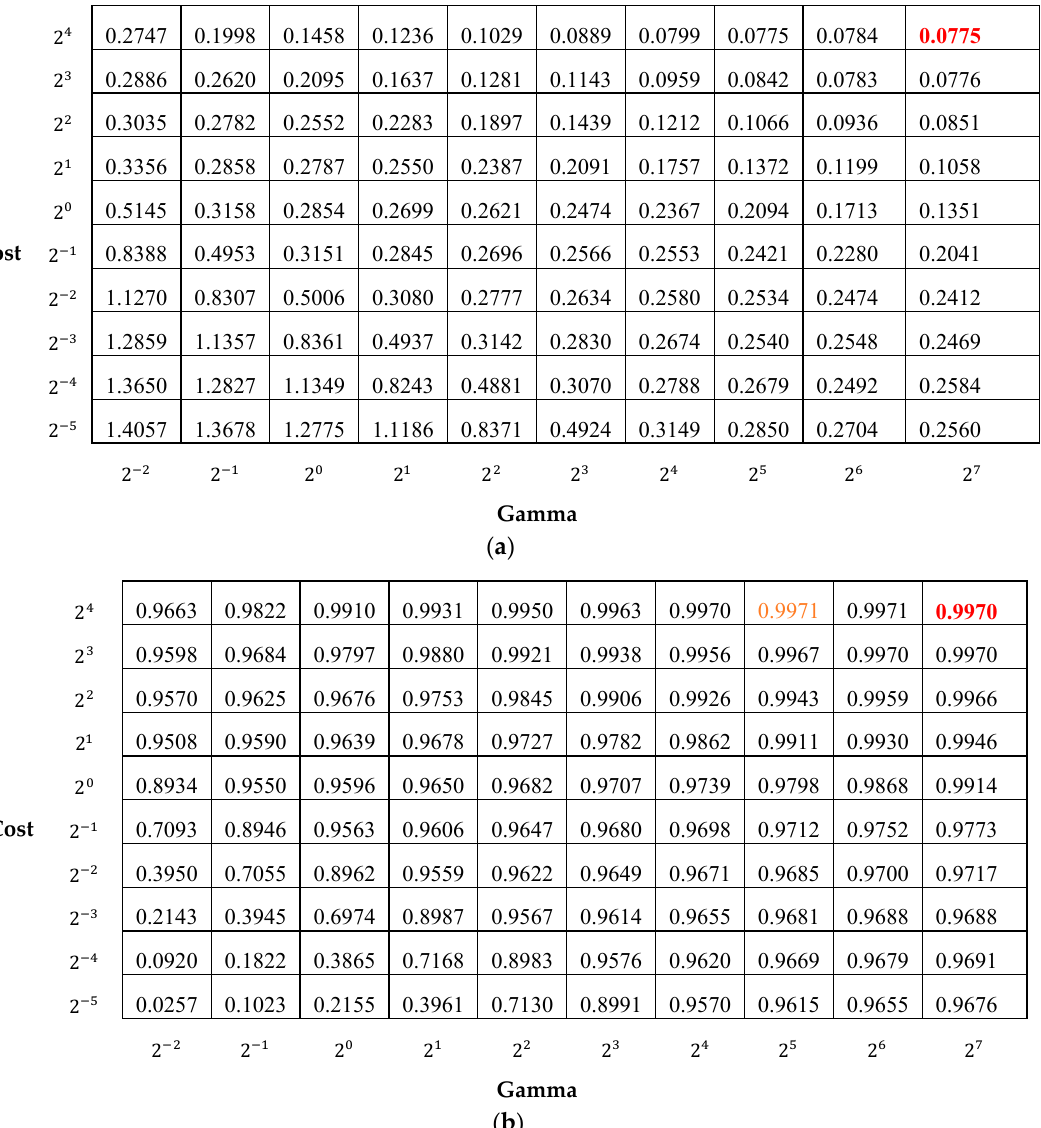
Figure 15. The mean score in the edge area of: ( a ) positioning accuracy and ( b ) CV.